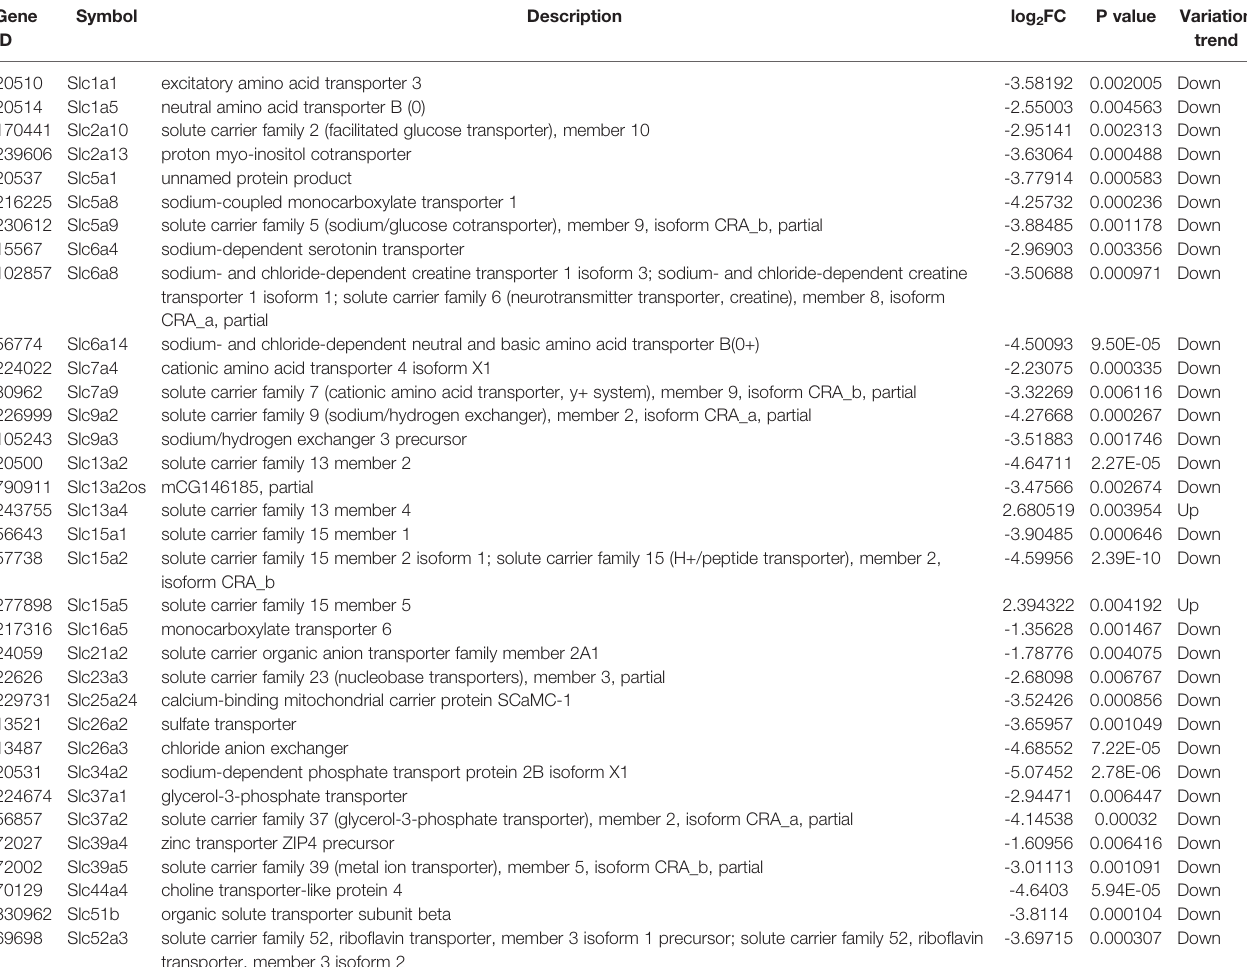
TABLE 1 | Slc transporters DEGs in liver compared between HFD group and NCD group (\log2FC\ ≥ 1 and P<0.01). Gene